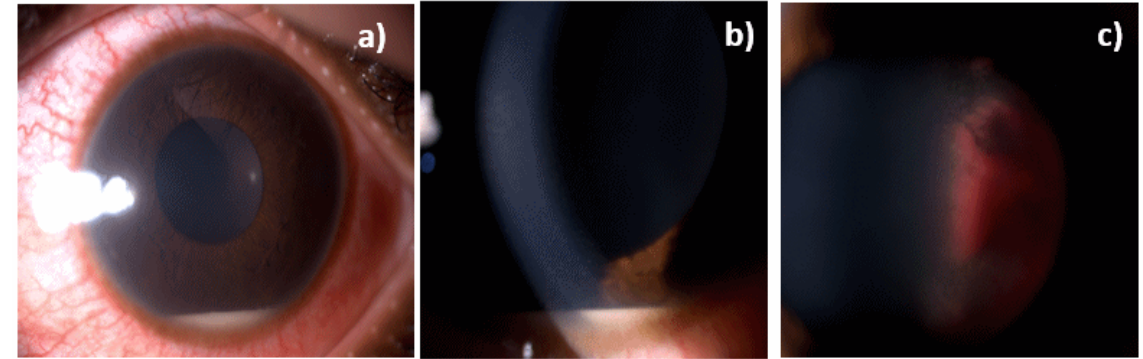
Figure 1: Biomicroscopy of the left eye showed a very small hypopyon, small, inferior, keratic precipitates, anterior chamber cells 4+, vitreous cells 3+, and a dense white mass was visible in the vitreous cavity along with organized vitreous hemorrhage.